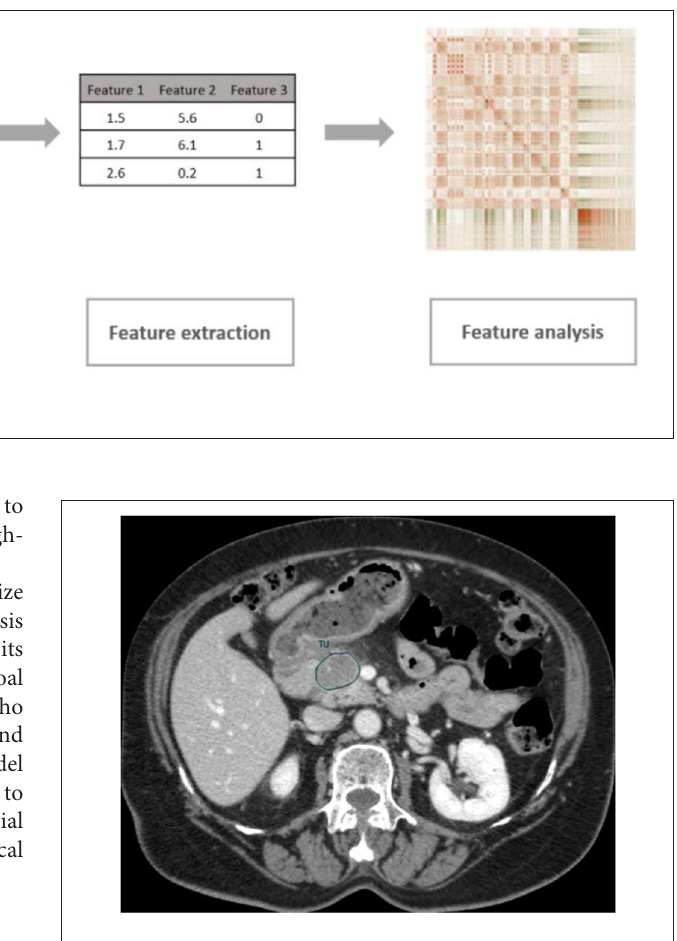
FIGURE 2 | A manual contour of CT scan from a representative patient in cohort